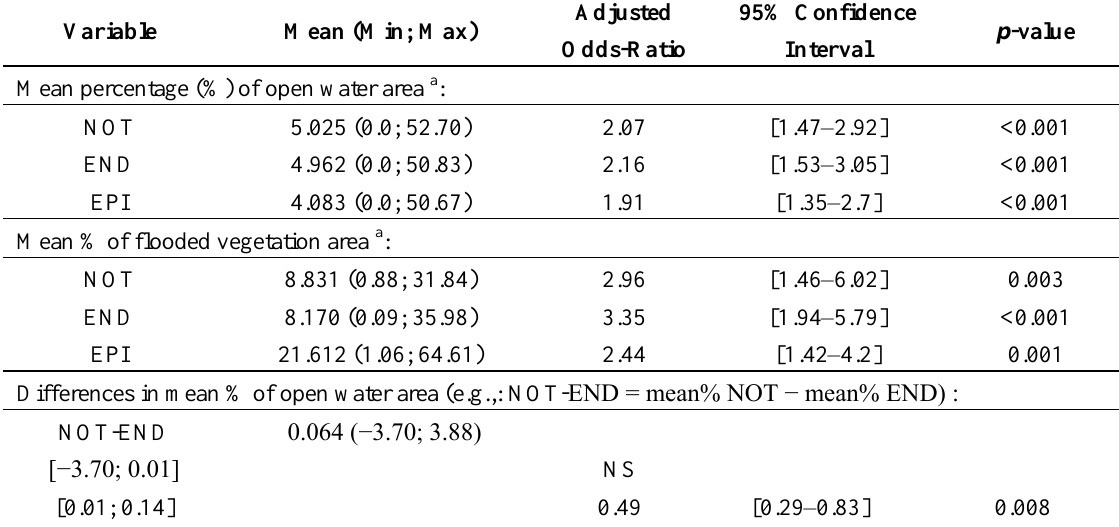
Table 2. Distribution and results of the univariate analysis for the environmental explanatory variables calculated in buffers of 2 km-radius around each stable and tested for their association with the serological status of WNV in equids in Southern France, 2007–2008. Adjusted 95% Confidence Variable Mean (Min; Max) Odds-Ratio